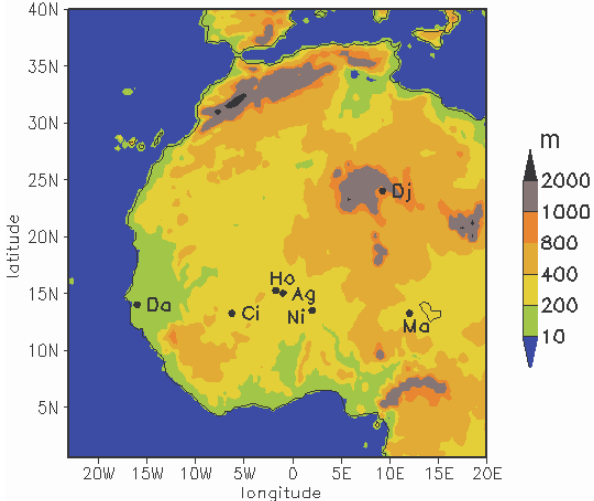
Figure 2: Model domain and stations used for comparison with model results. ( Ag – Fig. 2. Model domain and stations used for comparison with Agoufou, Ci – Cinzana, Da – Dakar, Dj – Djanet, Ho – Hombori, Ma – Maine Soroa, Ni – Niamey).